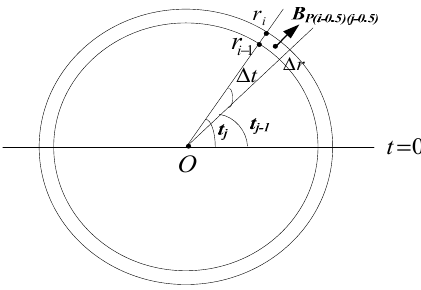
Figure 3. The magnetic field of one point on a circular cross-section of one turn.